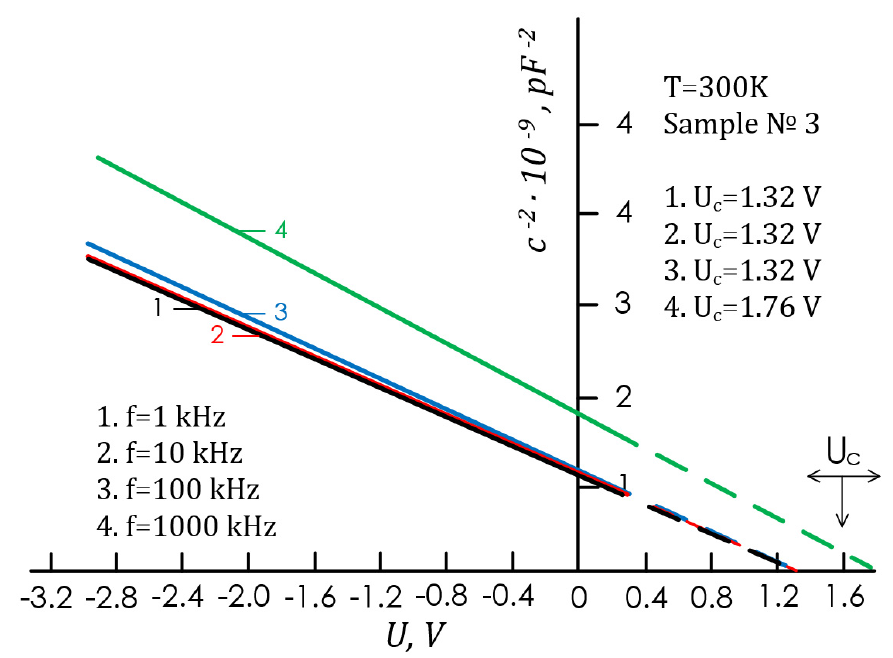
Figure 5. Differential capacitance dependence on the bias voltage for studied structures (No. 3, β = 1.39) at different frequencies (f).